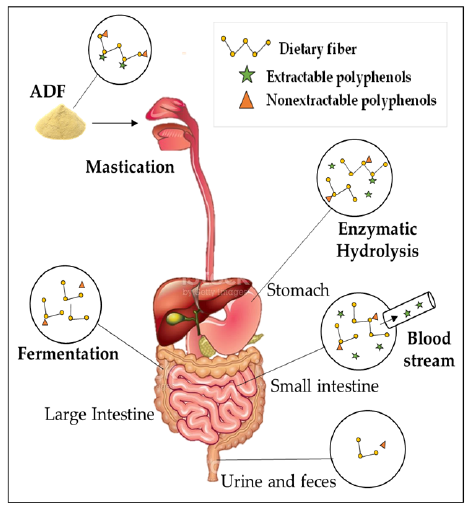
Figure 3. Bioavailability of phenolic compounds associated with dietary fiber.